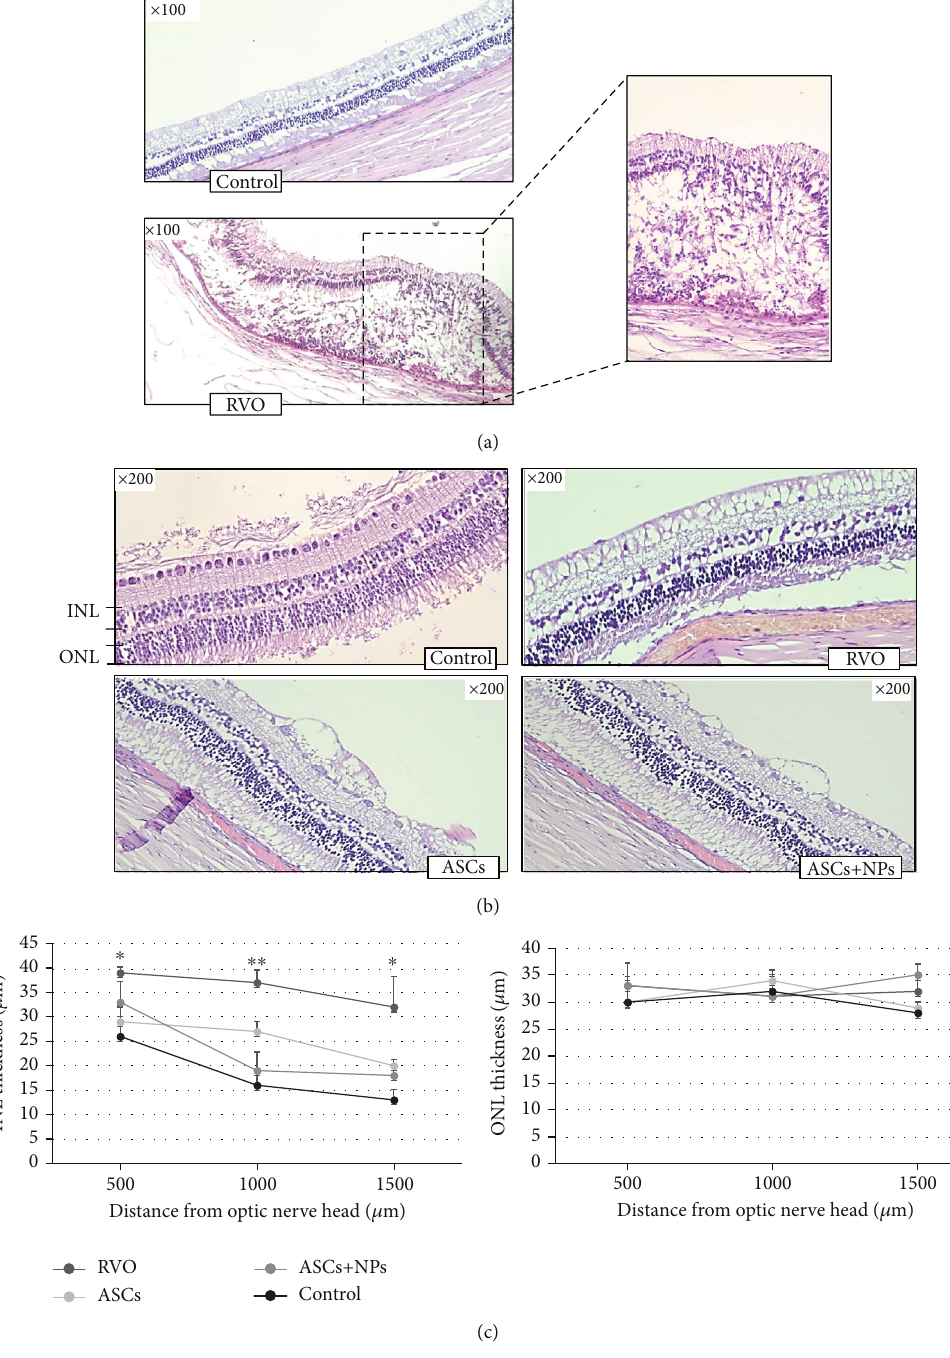
Figure 6: Representative images of H&E-stained retinas presenting: (a) retina disorganization and detachment in the RVO group; (b) the augmentation of INL in the RVO group and its following decrease in the ASC and ASC + NP groups. (c) Plots below illustrate quantitative INL and ONL thickness data. Data are expressed as the mean ± SD ( ∗∗ P < 0 : 01 , ∗ P < 0 : 05 vs. control; n = 2